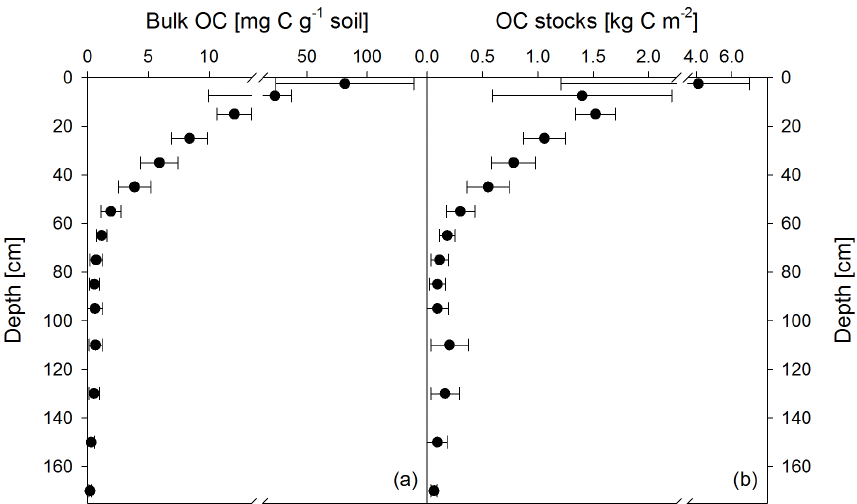
Figure 1. Mean bulk OC contents of both sampling times (November 2016 and May 2018) (a) and calculated OC stocks as the mean of both sampling times (b) . Apparent re-increasing OC stocks below 100cm are the result of doubling the thickness of the analyzed depth increments (i.e., 5cm increments from 0 to 10cm, 10cm increments from 10 to 100cm, and 20cm increments from 100 to 180cm). Data show the mean of 12 samples, and error bars depict the standard deviation.